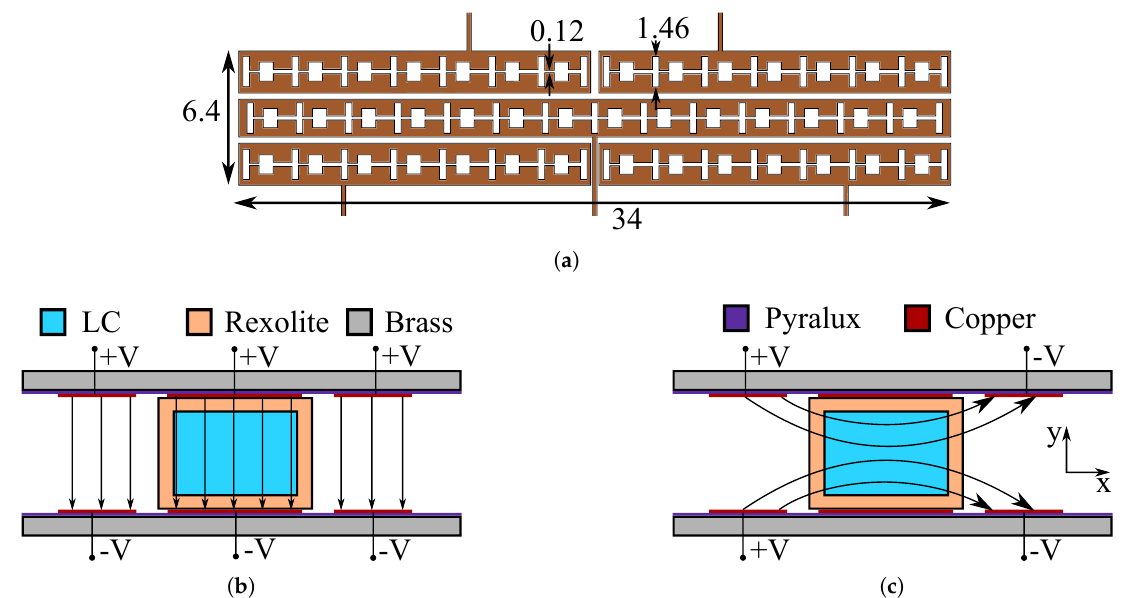
Figure 20. ( a ) Electrode design of the PPDW phase shifter with an inverted stepped impedance structure for mode suppression. All dimensions are given in mm. ( b , c ) show the bias configurations for parallel and orthogonal LC orientation, respectively.